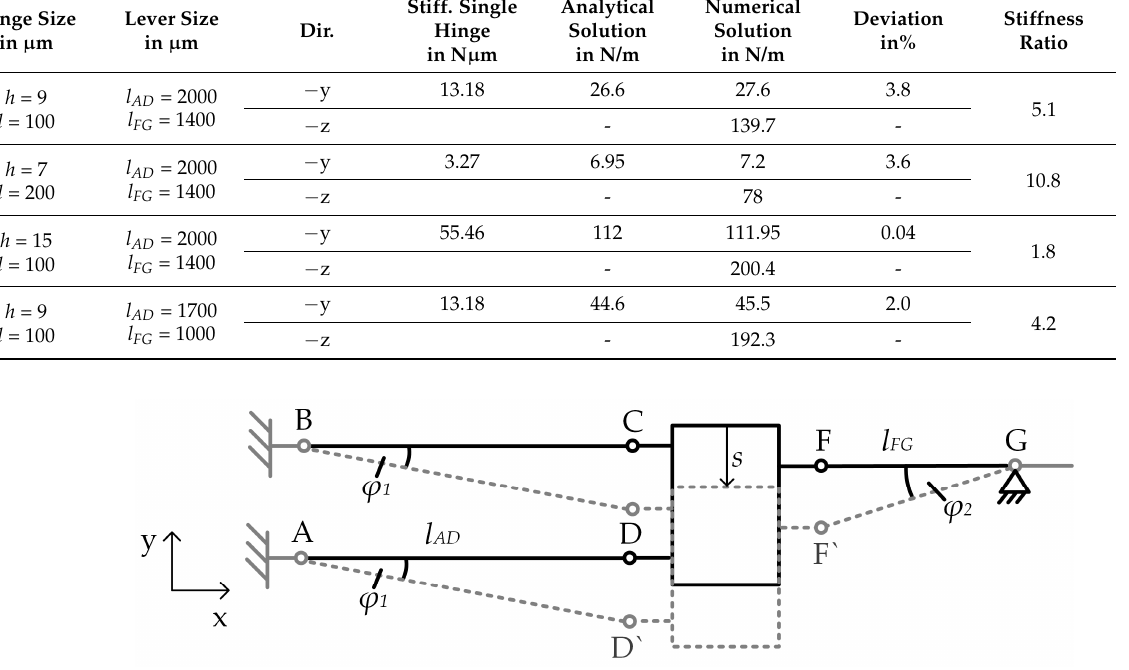
Figure 3. Simplified schematic of the MEMS-based weighing cell that was used for the analytical approach. Black: unloaded state, dashed grey: loaded/deflected state.